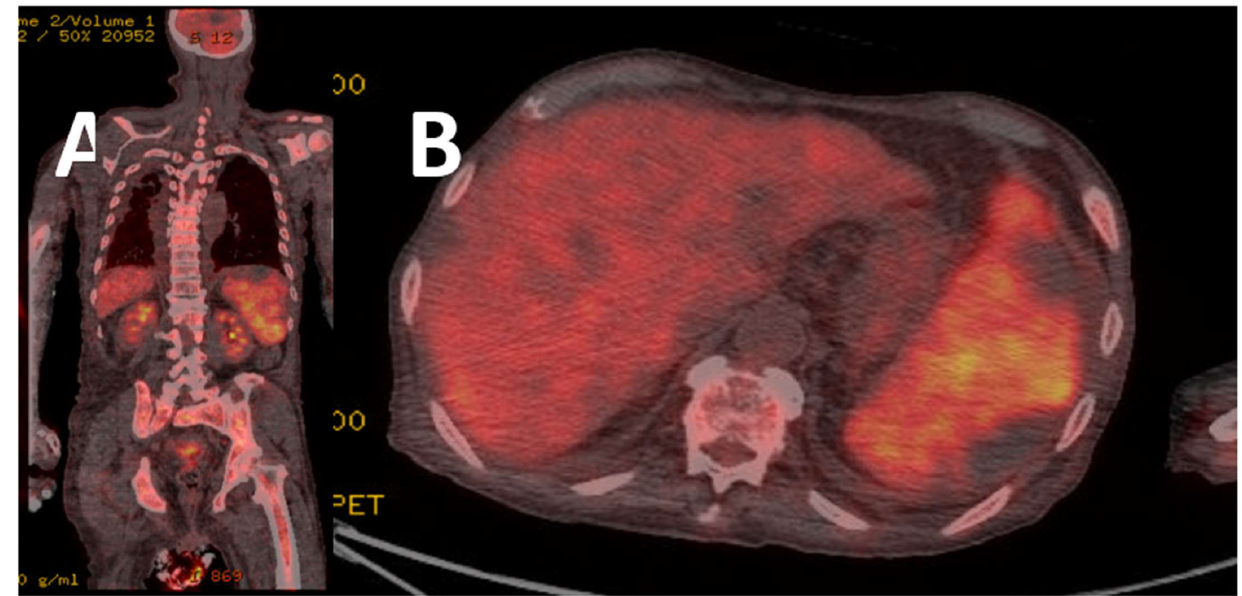
Figure 3. Results of the positron emission tomography–computed tomography (PET–CT). ( A ) Coronal view of the PET–CT, indicating diffuse F-18 fluorodeoxyglucose (FDG)-uptake in bone-marrow. ( B ) Axial view of the PET–CT, revealing splenomegaly with diffuse FDG uptake, wedge pattern of photon defects in low density indicating lymphoma involvement concomitant splenic-infarction with diffuse- and mild-FDG-uptake in the liver.